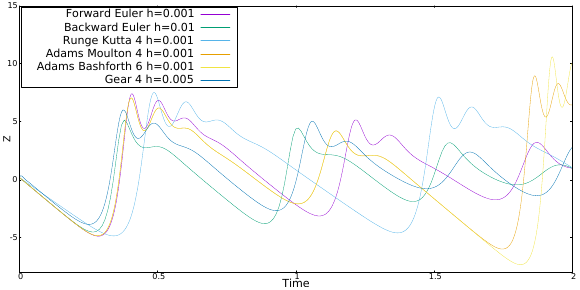
Figure 2. Time series of z of CO3 given in Table 1 with initial conditions x 0 = y 0 = 0.1, z 0 = 0.0.